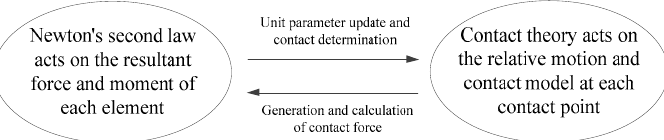
Figure 1. Cycle calculation relationship.